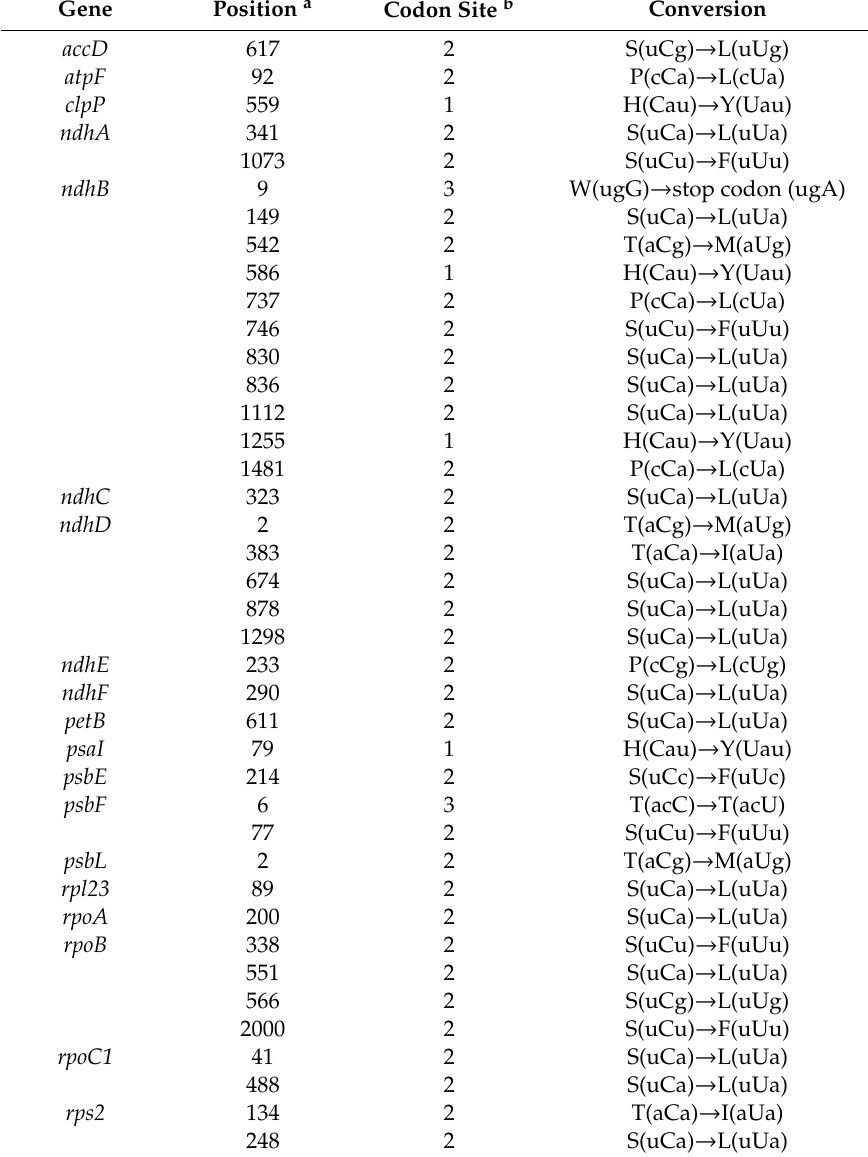
Table 2. RNA editing sites in soybean chloroplast